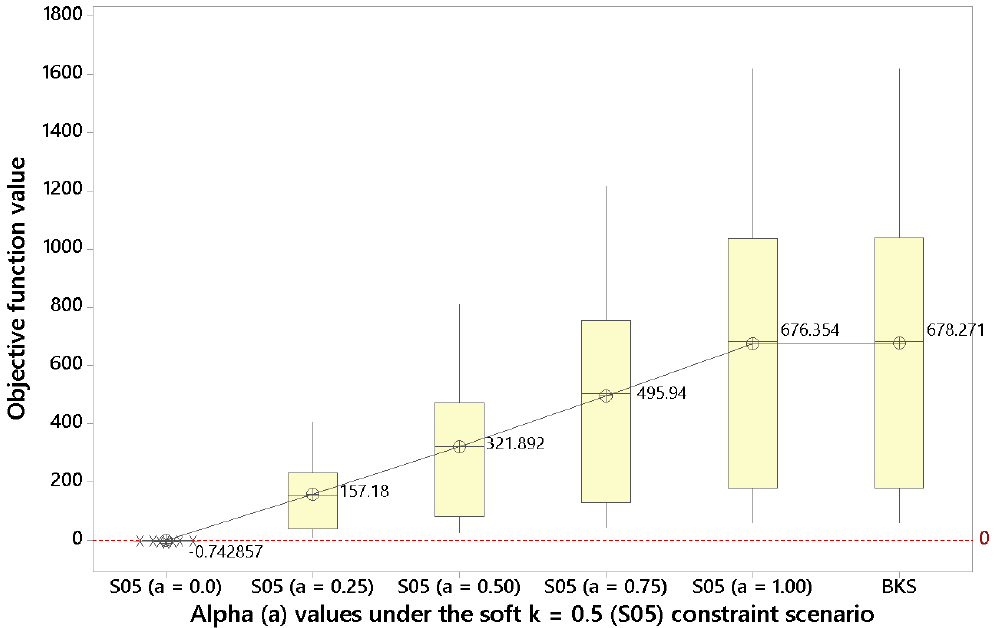
Figure 3. Results for different alpha values under the soft constraint scenario with k = 0.5 (source: own